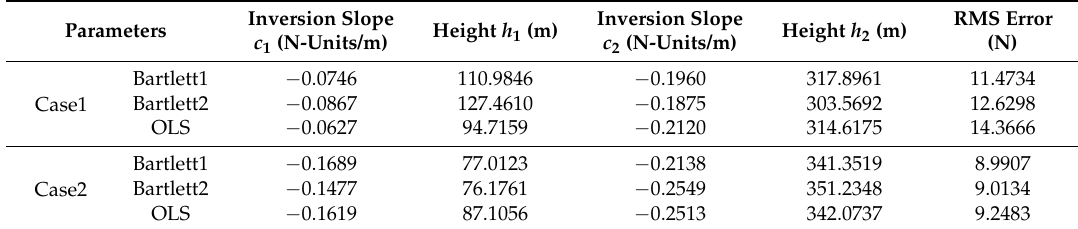
Table 5. The value of inversion parameters by different inversion